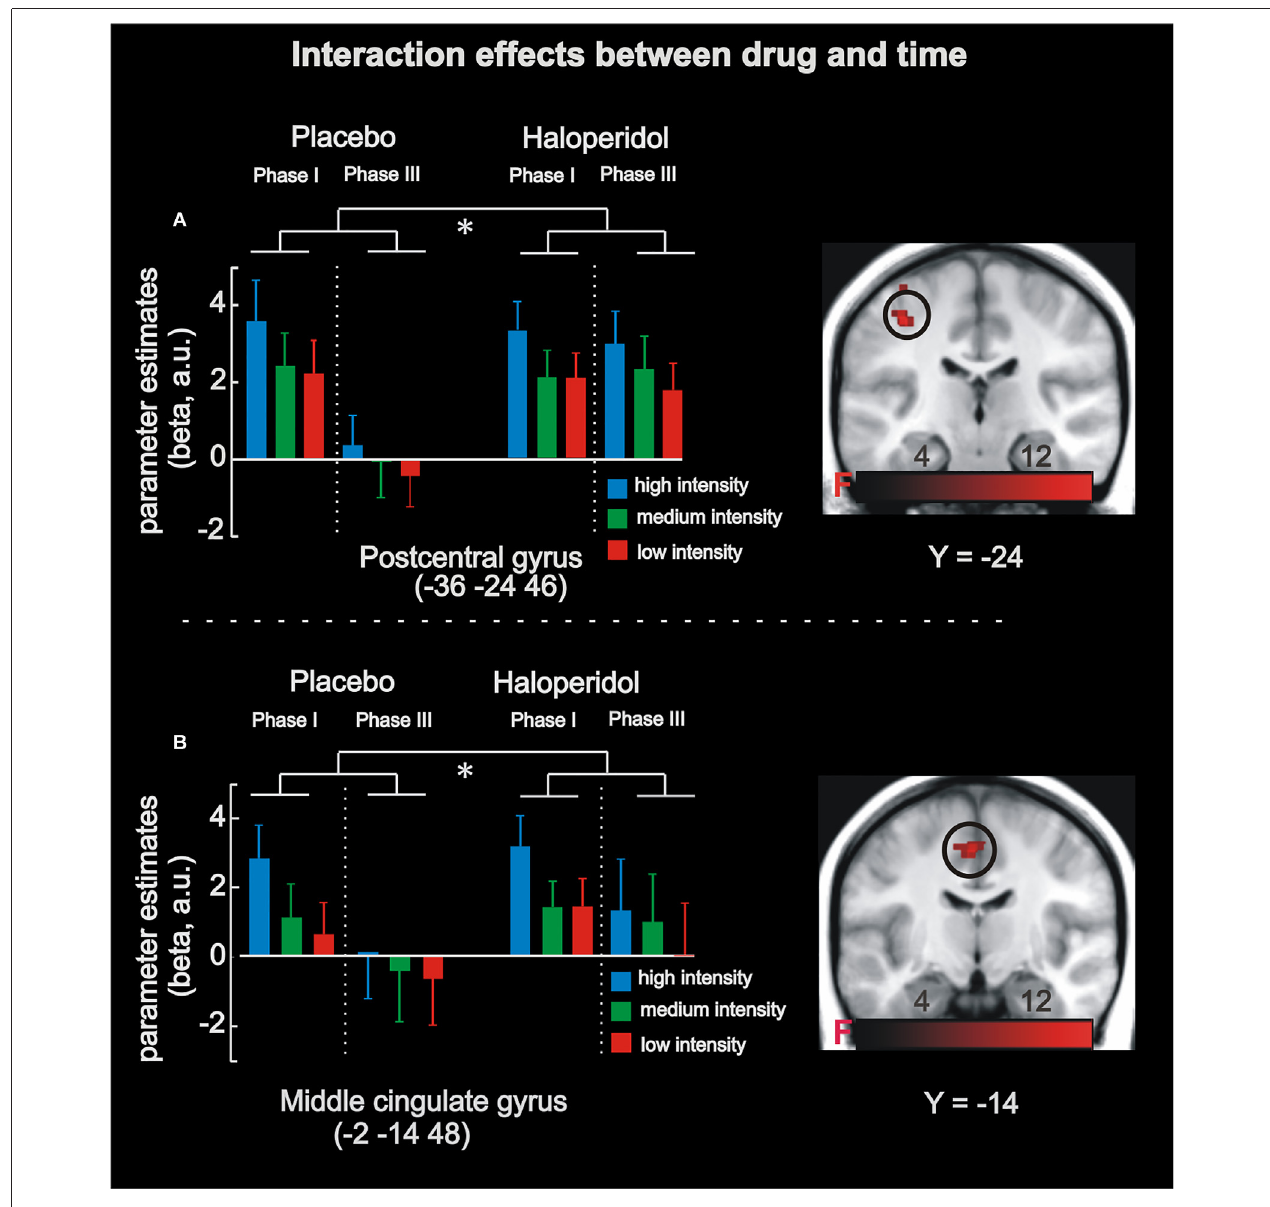
FIGURE 3 | fMRI results in the absolute task. Analyses revealed a significant interaction between stimulation magnitude, drug and time in left postcentral gyrus (A) and left midcingulate cortex (B) . Under placebo in phase I, activity increased as a function of stimulation magnitude (absolute coding), and this effect was absent in phase III (i.e., habituation). Under haloperidol, however, there was no significant habituation from phase I to phase III. The significant interaction effects are highlighted by the asterisk. Maps of activations are superimposed on a T1 group template. Error-bars denote one standard error of the